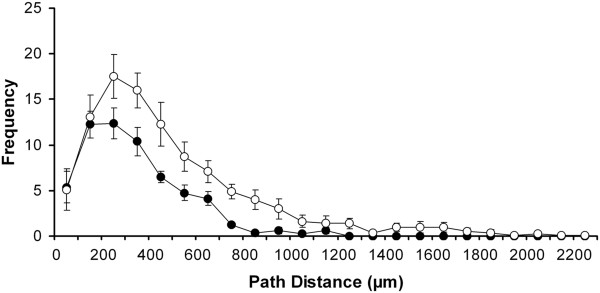
Spatial distributions of branch points in dendritic trees of limb moving MNs. Distances of branch points were measured along dendritic paths from the soma. Closed and open circles stand for the cervical and lumbar MNs respectively. Both the mean total numbers and the distributions of branch points are significantly different (Mann–Whitney test, p < 0.005; Wilcoxon test, p < 0.0005) in MNs of the cervical and lumbar parts of the frog spinal cord.